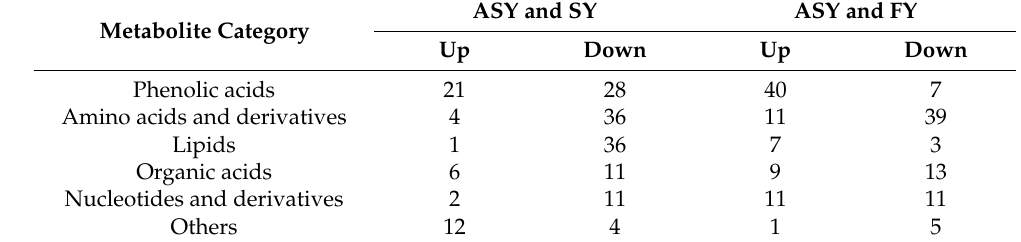
Table 1. The detailed amount of difference metabolites among different comparison phenotypes of F. cirrhosa (ASY is control phenotype for calculating the up- and downregulated components).